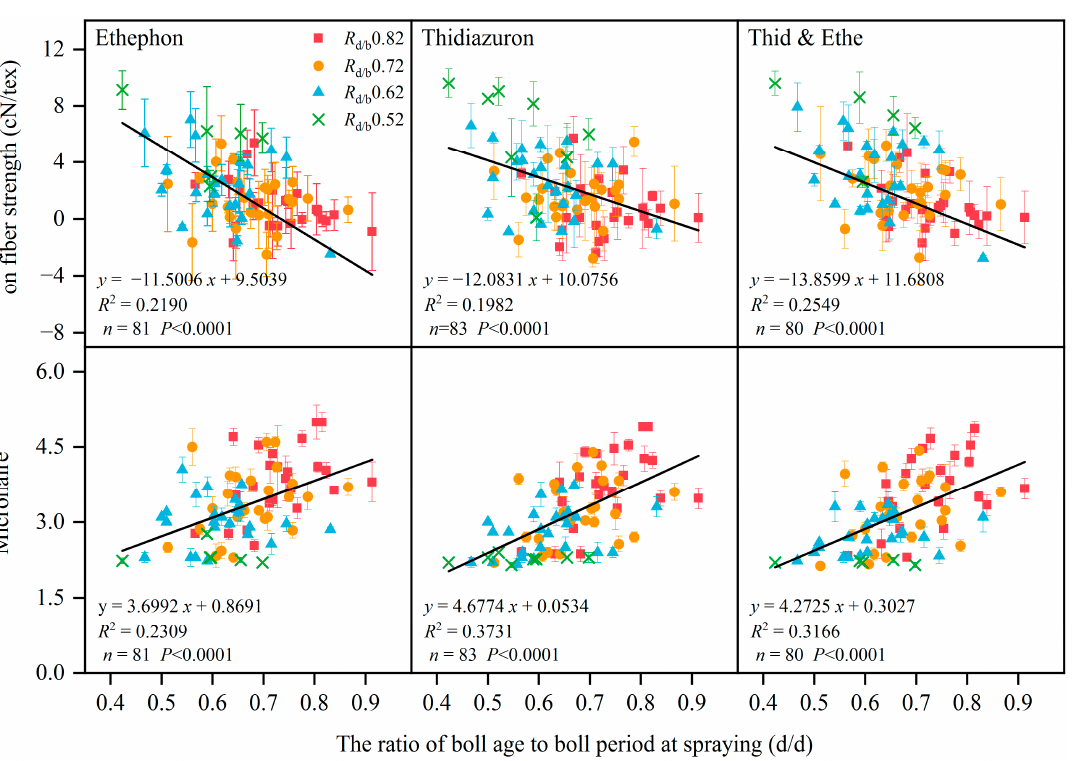
Figure 9. Quantitative relationship between the fiber strength damage, micronaire value, and R d/b value. The R d/b value in the figure indicates the ratio of the cotton boll age (d) when the harvest aids were sprayed in the control boll period (b), and the control boll period (b) is the boll period with no spraying of harvest aids.